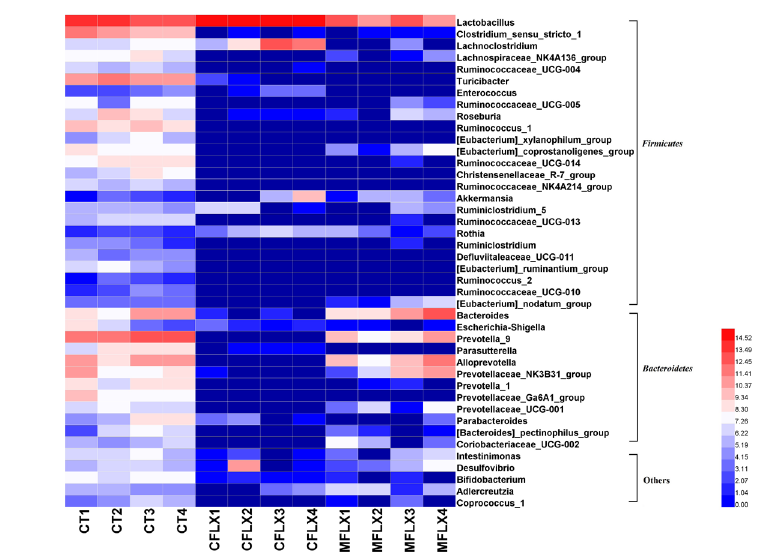
FIGURE 4 - Heatmap of ciprofloxacin and moxifloxacin modulation on the gut microbiota of normal rats treated with 100 mg/ kg/day ciprofloxacin and 40 mg/kg/day of moxifloxacin orally for seven days. The heatmap was generated using HemI 1.0.3.7. Red indicates an increased value, whereas blue indicates a decreased